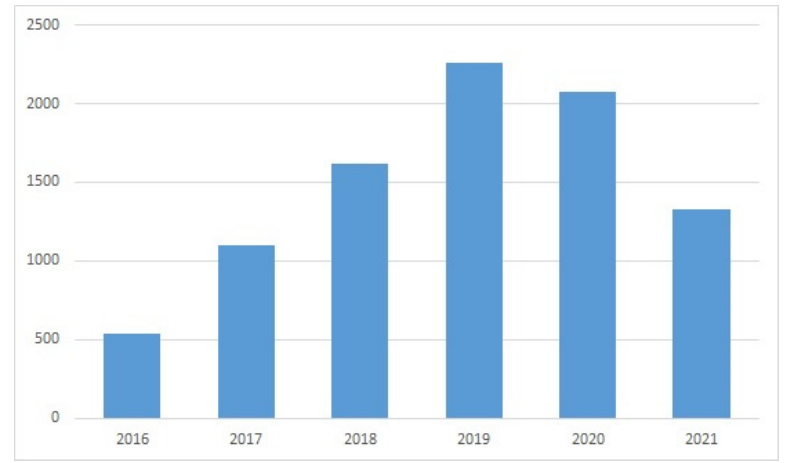
Figure 8. Evolution of publications in WoS for “remotely operated vehicle” OR “ROV” AND “design” (year, number of publications).